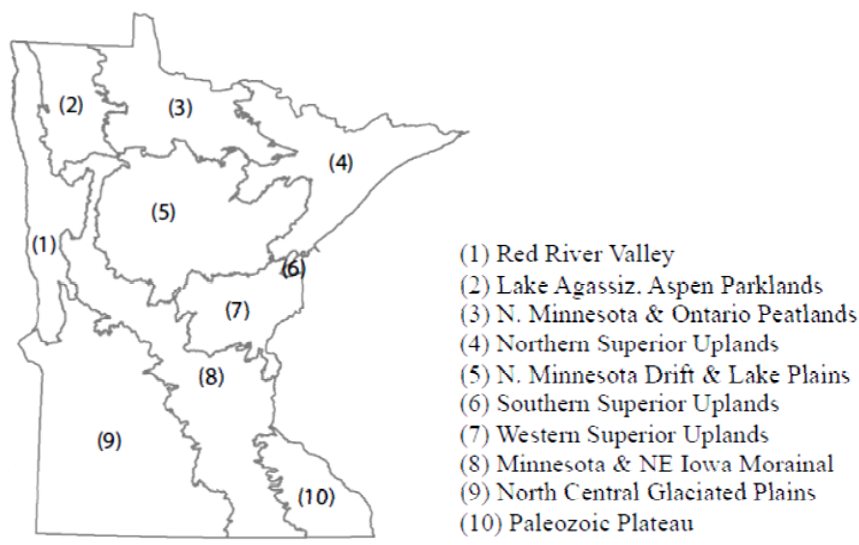
Figure 1. Minnesota’s ecological sections.